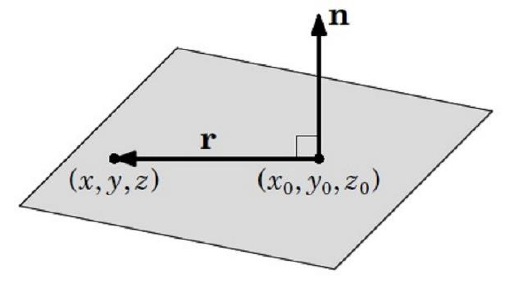
Figure 2. Normal vector on plane P at point P 0 = (x 0 , y 0 , z 0 ) (Corral,